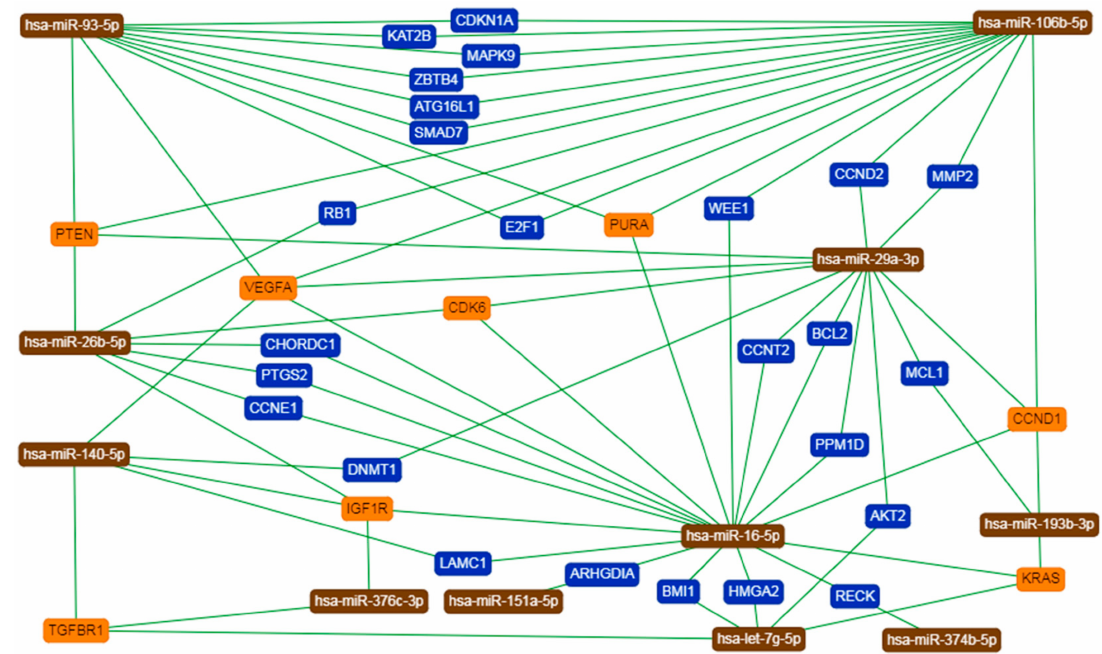
Figure 7. Network of interactions between several core miRNAs and their validated target genes provided by miRTargetLink Human. Orange describes genes interacting with at least three miRNAs, while blue shows genes targeted by two